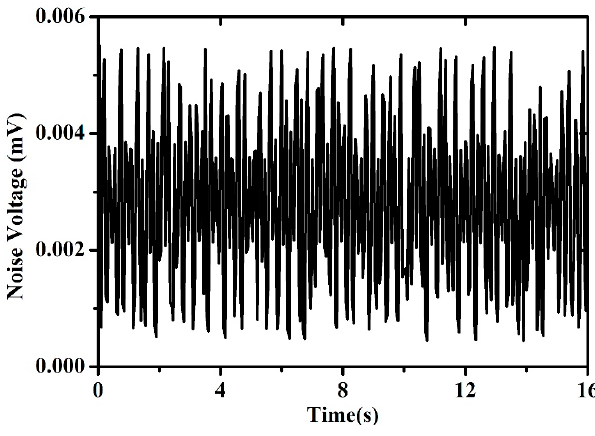
Figure 11. Output noise of the type B sensor plotted as a function of time in the zero-flow case.